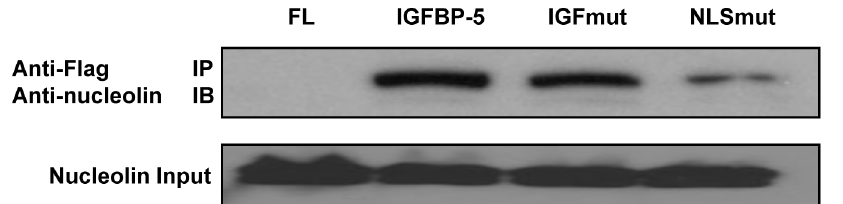
Fig 6. Mutating the NLS domain of IGFBP-5 reduces its ability to bind nucleolin. The interaction of Flag- tagged IGFBP-5 and nucleolin was detected using immunoprecipitation using anti-Flag antibody followed by immunoblotting to detect nucleolin. Input nucleolin was detected in lysates prior to co-precipitation to ensure that samples contained equivalent amounts of protein.